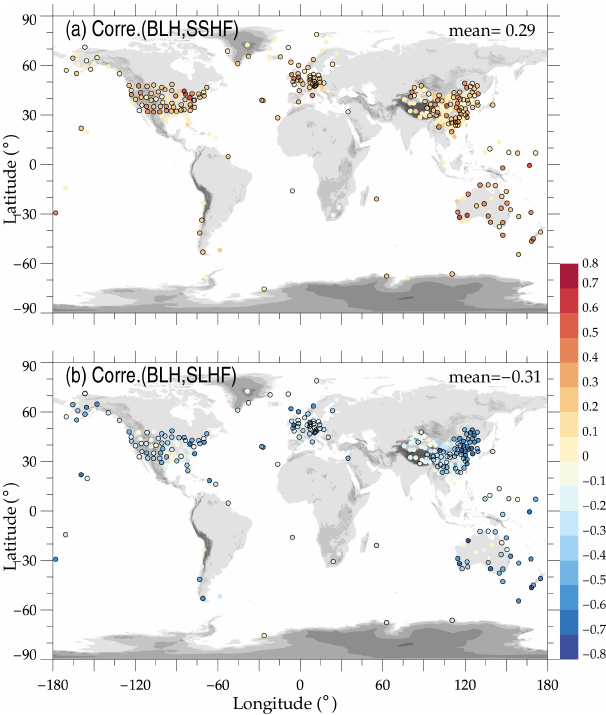
Figure 6. Similar to Fig. 5 but for the correlations between BLHs versus normalized surface sensible (a) and latent (b) heat